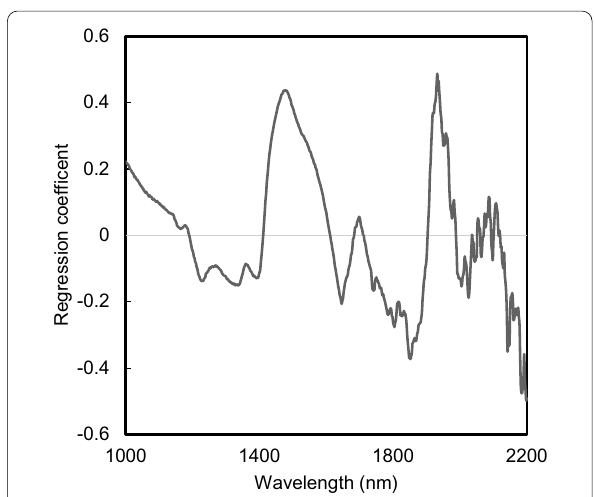
Fig. 4 The regression plot of the optimum PLS regression